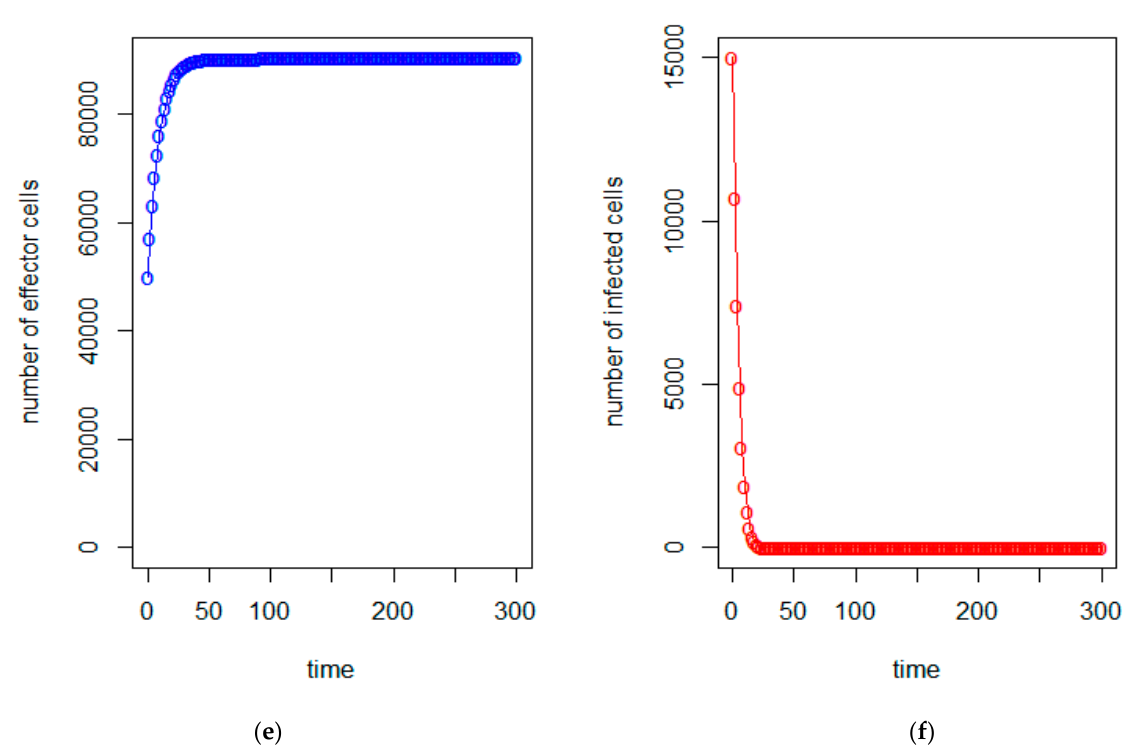
Figure 3. ( a , b ): The immune-effector cells ( a ) and virus-infected cells ( b ) vs. time (days); ( c , d ): The immune-effector cells ( c ) and virus-infected cells ( d ) vs. time (days). The same as Case 3, except I 0 = 75,000 cells; ( e , f ): The immune-effector cells ( e ) and virus-infected cells ( f ) vs. time (days). The same as Case 3, except V 0 = 15,000 cells. Case 4 : The same as Case 3 (i.e., b =43 × 10 − 7 , a = 0.043), except s = 10,000 (instead of s =